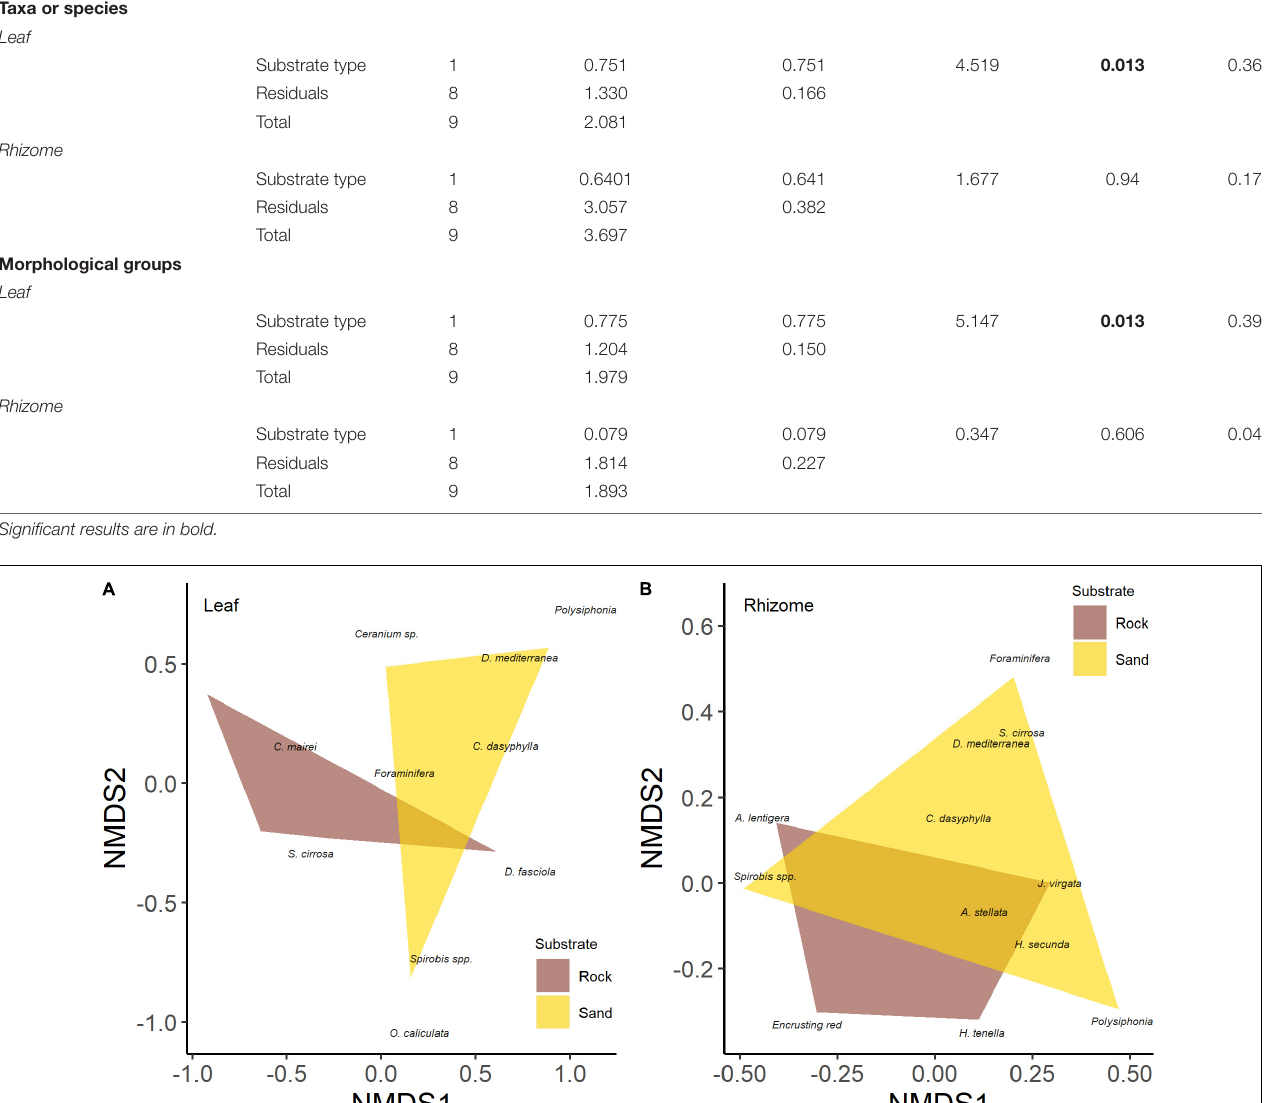
TABLE 3 | Results of multivariate analysis of the epiphyte community (at the level of taxa and algal morphological groups) on leaves and rhizomes of five-year old Posidonia oceanica seedlings grown on rock and sand substrates. Source Sum of squares Mean squares Pseudo-F